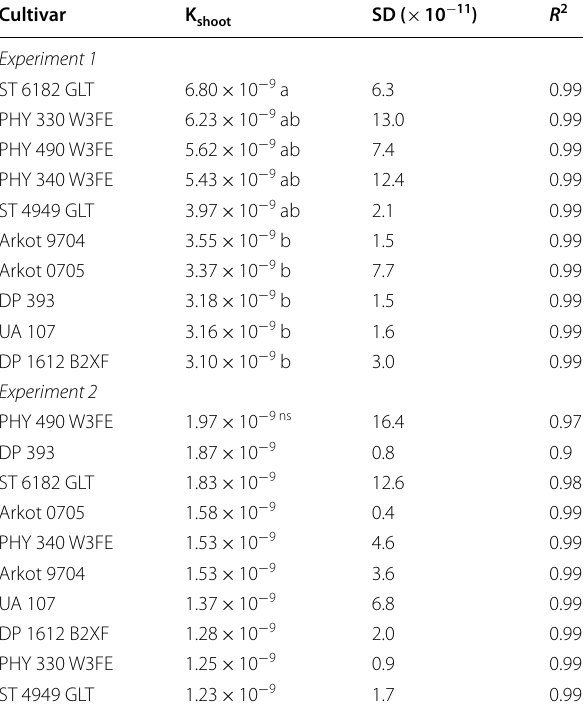
Table 1 Shoot hydraulic conductance (K s − 1 MPa − 1 ), standard deviation (SD), and R 2 response of cotton cultivars in Experiment 1: (38 °C, vapor pressure deficit (VPD) > 3 kPa) and Experiment 2: (32 °C, VPD controlled environments